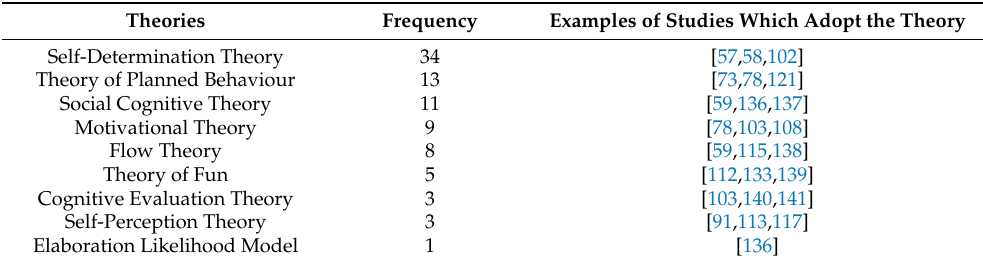
Table 2. Adopted theories and their frequencies in BCG